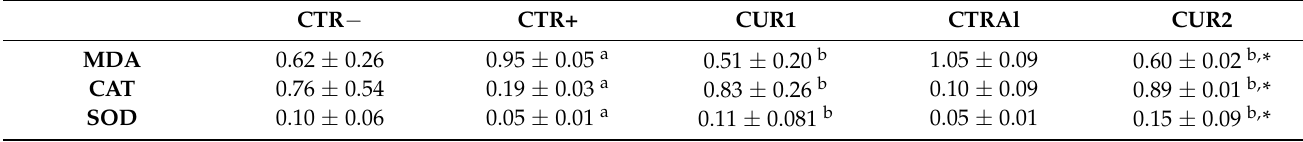
Figure 3. Effect of co and post-treatment of curcumin on the hippocampus acetylcholinesterase activity on rat model of AD induced by chronic administration of AlCl 3 .Values are mean ± SEM. Note: CTR − : negative control group; CTR+: positive control group (treated by aluminum chloride (AlCl 3 )); CUR1: co-treatment with curcumin; CUR2: post-treatment with curcumin; CTRAl: exposed to AlCl 3 for 90 days and survive 60 days without any treatment; a: p < 0.05 as compared to CTR- group; b: p < 0.05 as compared to CTR+ group; *: p < 0.05 as compared to CTRAl group, repeated measures two-way ANOVA followed by Tukey’s test for multiple comparisons. Table 2. Effect of co and post-treatments by curcumin on aluminum chloride-induced oxidative stress in rat